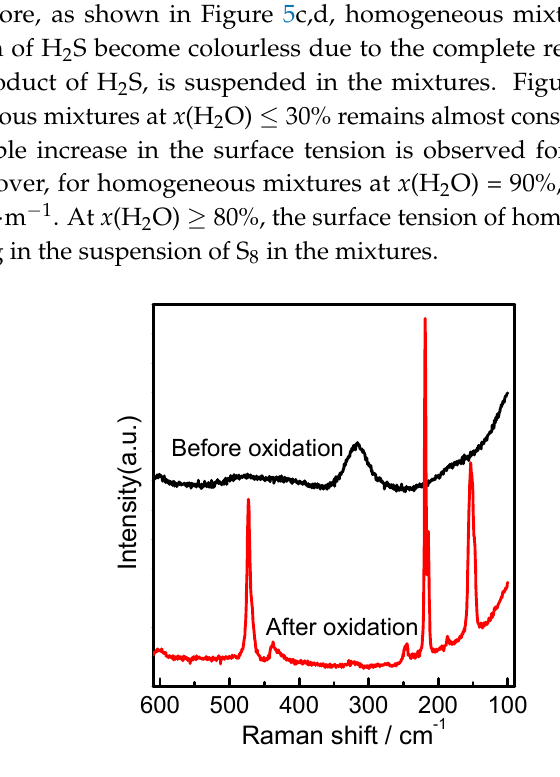
Figure 4. Raman spectra for the homogeneous [bmim]Fe(III)Cl 4 –H 2 O mixture at x (H 2 O) = 80% before and after oxidative-absorption of H 2 S.